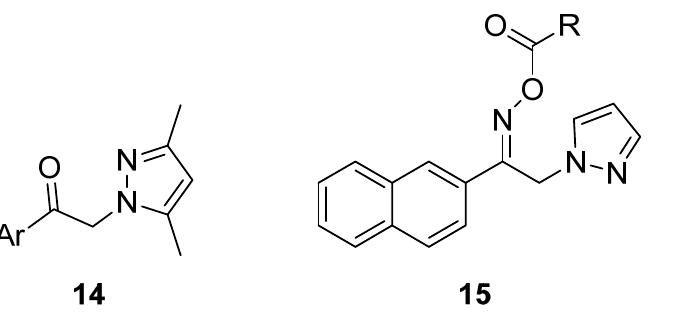
Figure 4. The 2-(3,5-dimethyl-1 H -pyrazol-1-yl)-1-arylethanone derivatives ( 14 ) and oxime ester derivatives carrying a pyrazole ring with cytotoxic activity ( 15 ).